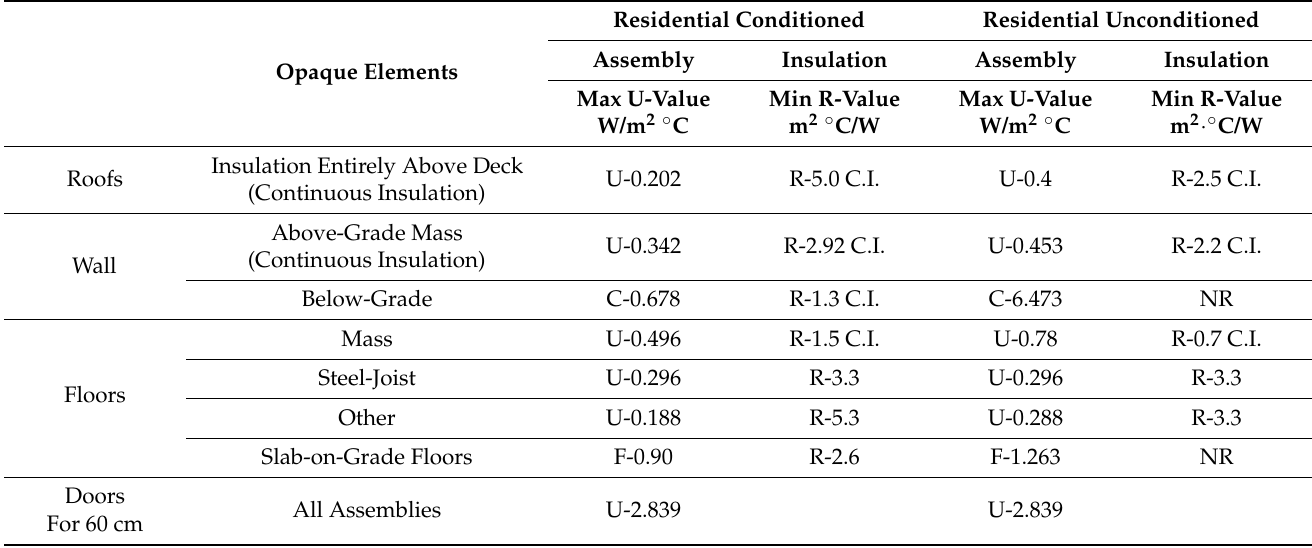
Table A1. Building Envelope Requirements for Zone 1